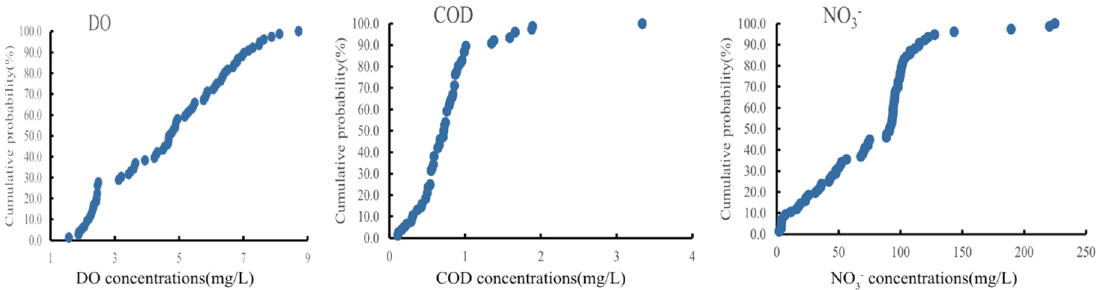
Figure 2. Cumulative probability curve analysis of dissolved oxygen (DO), nitrate (NO 3 − ), and chemical oxygen demand (COD) concentrations in shallow groundwater.